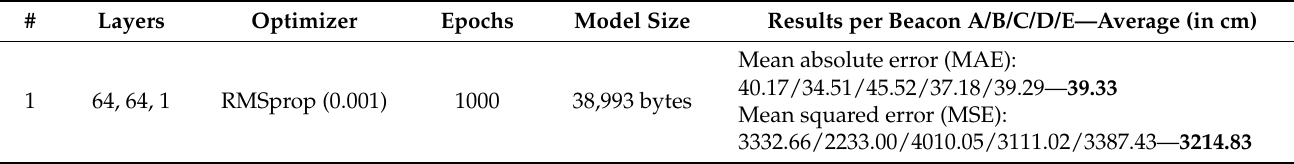
Table 1. Experiment No. 1 parameters and results.